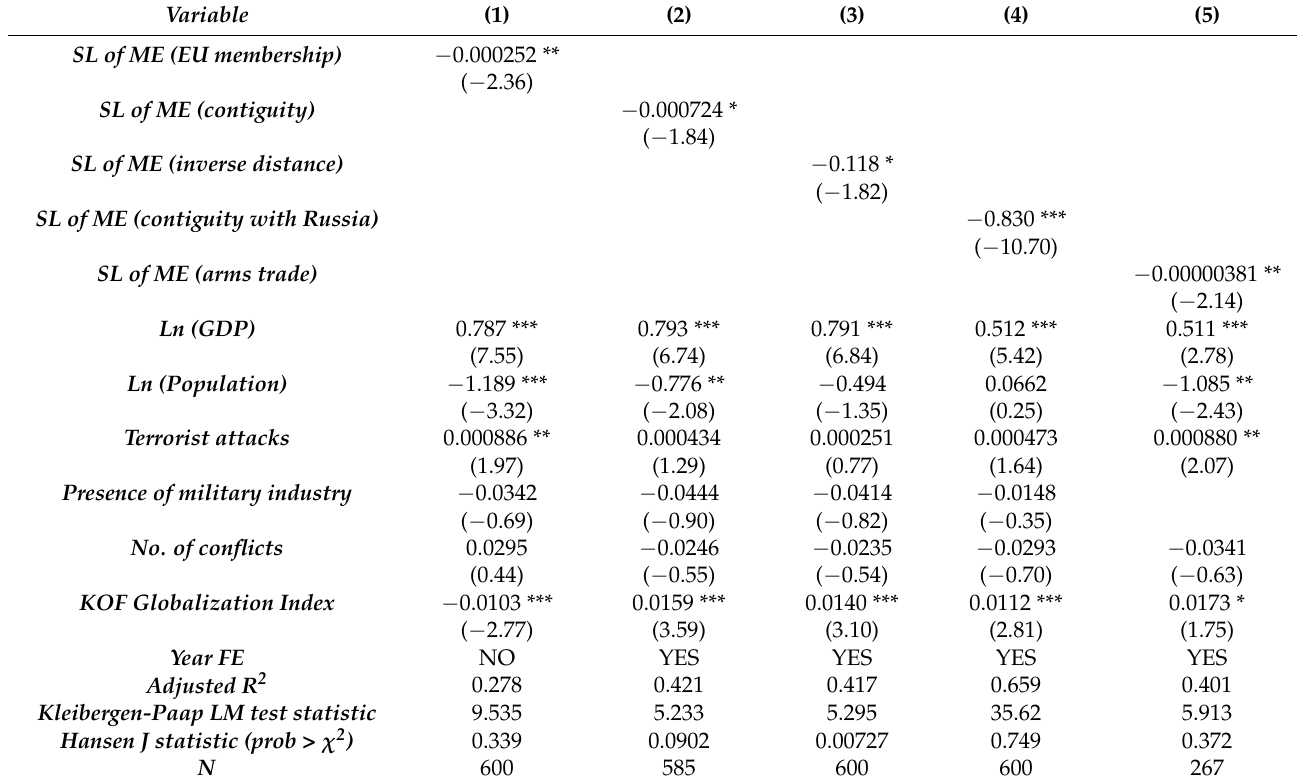
Table 6. EU military expenditure, 1990–2019 (robustness